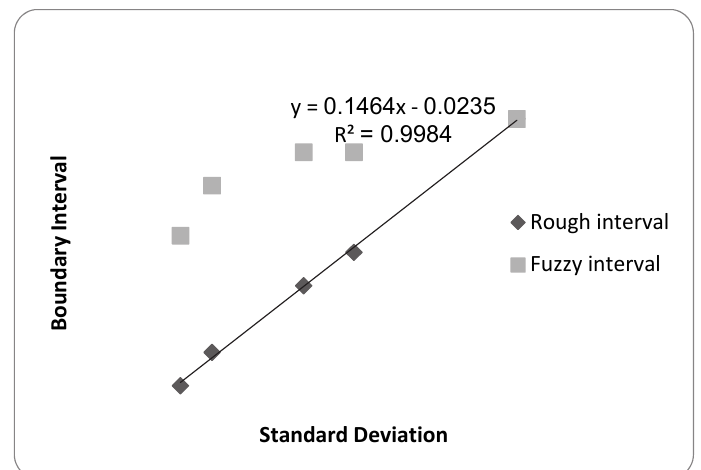
Fig. 3. Boundary interval v/s sample standard